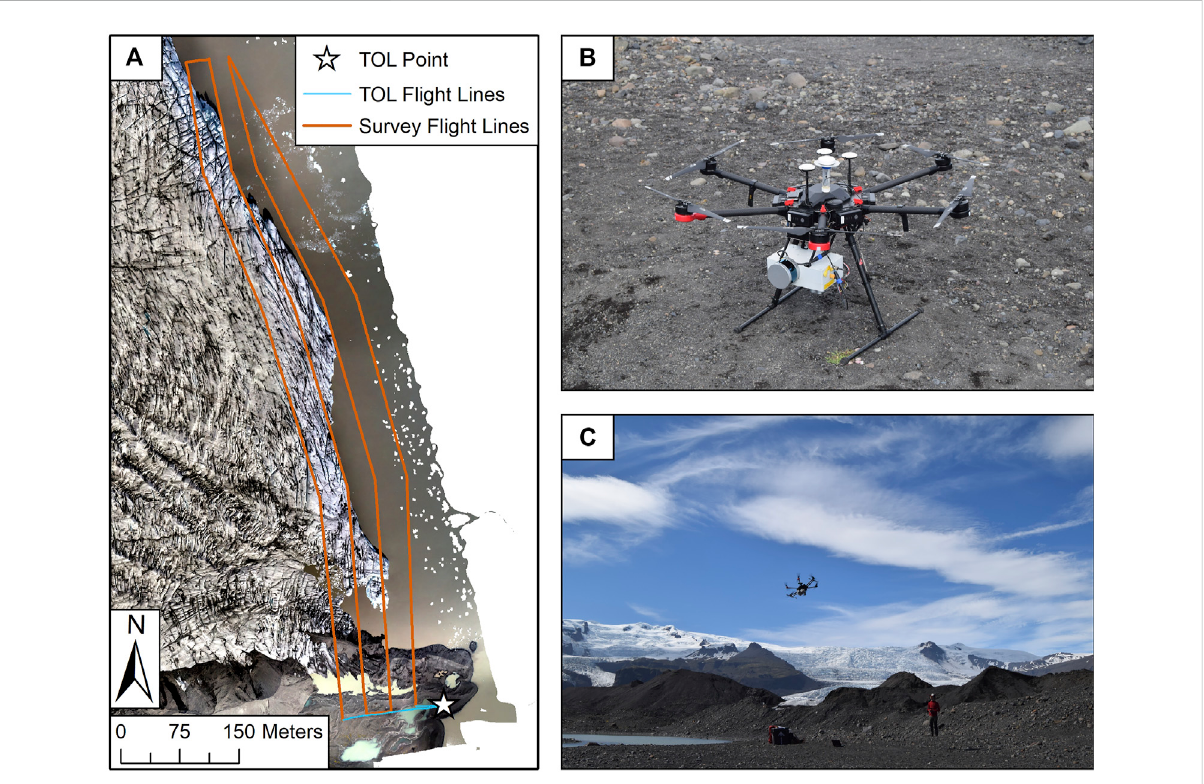
FIGURE 2 (A) Map illustrating the angled fl ight lines and areal coverage of the surveys fl own in this study. Take-off and landing point (TOL) is given by the white star. Background is a UAV-SfM orthomosaic from 8th July 2021. (B) Our custom UAV system. The survey box, to which the laser scanner was attached, can beseen below theUAV body. This con fi gurationwas used for all surveys. (C) Exampleimageof theinitialisation procedure undertaken before each M600 survey, as recommended by